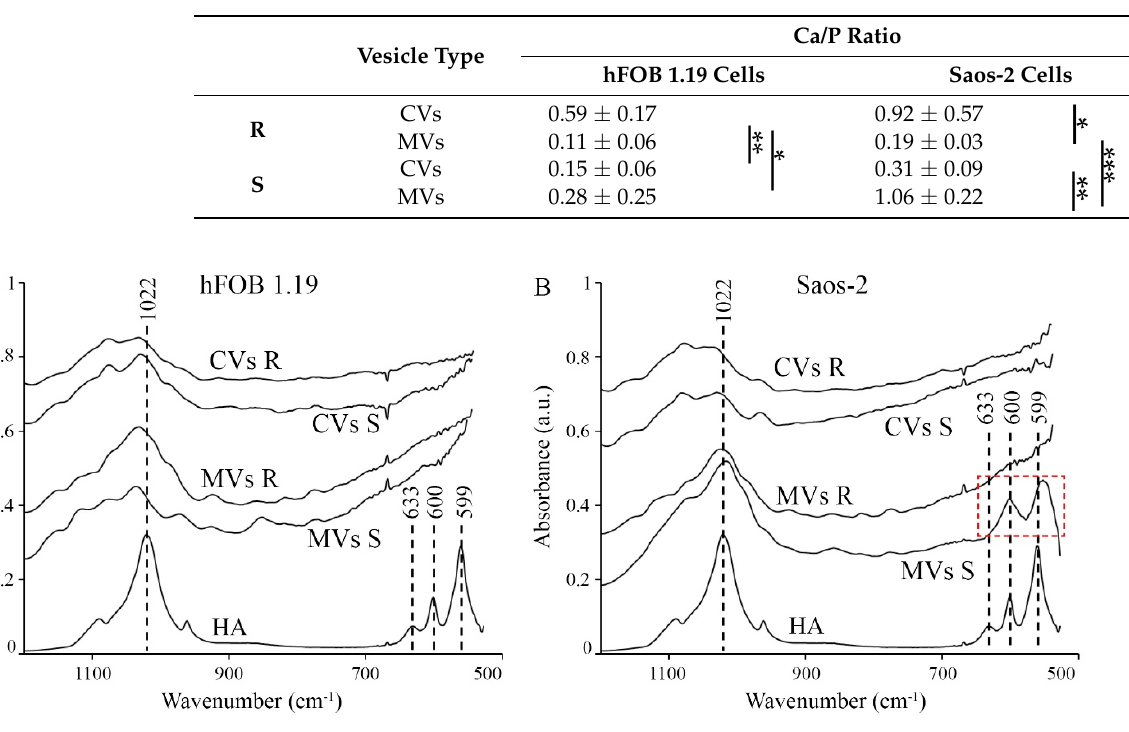
1.19 cells as compared with control cells without inhibitor (Figure S2A,B, stripped). Figure 3. IR spectra of minerals formed by vesicular fractions of hFOB 1.19 ( A ) and Saos-2 ( B ) cells. Vesicular fractions were purified from the extracellular matrix (MVs) and from the cytoplasm (CVs) of collagenase-treated cells in resting conditions (R) or after stimulation with AA and β -GP (S). The vesicular fractions were dried. IR spectrum of apatite (HA) is characterized by peaks 1022, 633, 600, and 559 cm − 1 . The red rectangle indicates the presence of HA in the fraction of MVs derived from the Saos-2 cell line stimulated for mineralization. IR spectra were averaged from three independent samples, each measured at two distinct locations of the batch (n = 6). IR spectra were up scaled by 0.2 A to be better visible. Table 1. Ca/P ratio calculated for vesicular fractions derived from extracellular matrix (mostly MVs) and cytoplasm (CVs) of collagenase-treated hFOB 1.19 or Saos-2 cells in resting conditions (R) or after stimulation with AA and β -GP (S). Data are means ± s.e., n = 8–18 measurements of three independent experiments (* p < 0.05, ** p < 0.01, and *** p < 0.001). Vesicle Type